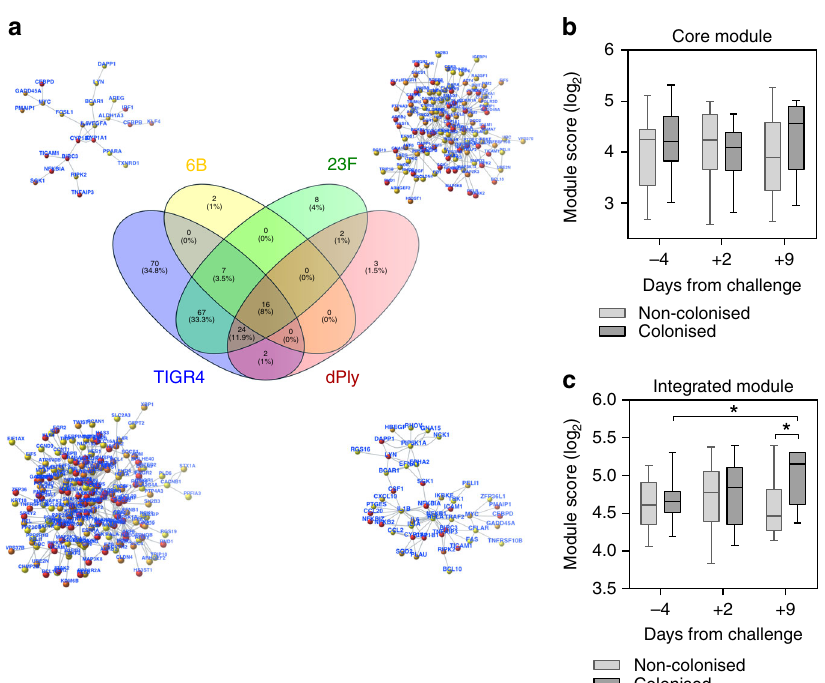
Fig. 7 Epithelial transcriptomic responses coincides with bacterial clearance in vivo. a Network representation generated from the in vitro analyses for each strain. From the genes present in the networks, an integrated gene list (200 genes) and a core genes list (16 genes) were generated and tested as modules in the in vivo data. b , c Upregulated genes in comparison to the transcriptomes of carriage negative and carriage positive volunteers were compared between time points. Plots represent log2 TPM arithmetic mean for genes in the core ( b ) and integrated ( c ) modules. P = < 0.05, (one tail Mann – Whitney test). Number of samples for carriage negative and positive, respectively: pre (17:14), day 2 (15:14), day 9 (7:7). Boxplots represent the median (centre line) and interquartile range (box), minima and maxima